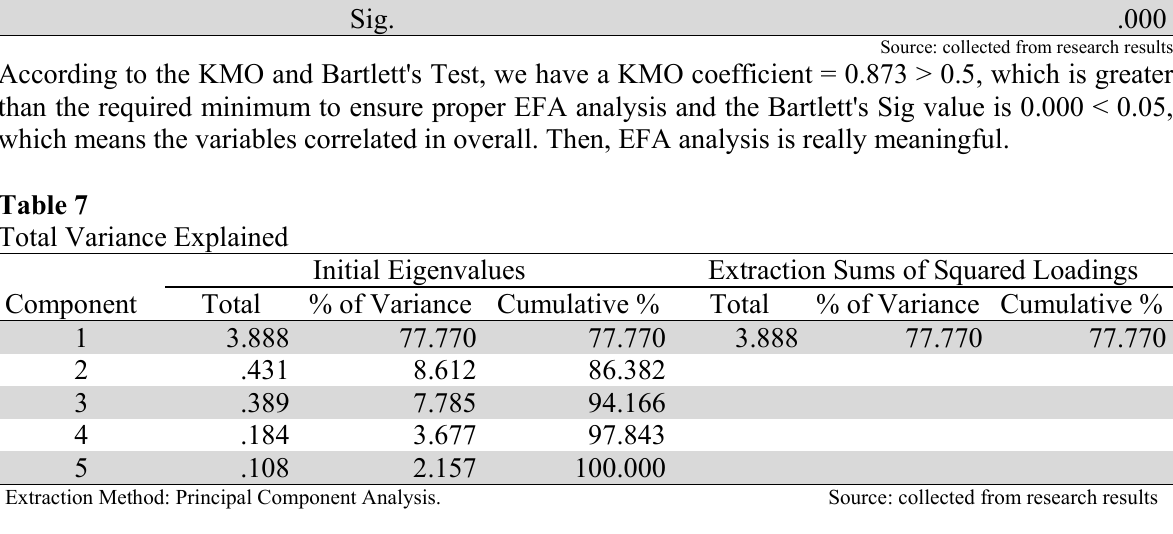
KMO and Bartlett's Test Kaiser-Meyer-Olkin Measure of Sampling Adequacy. Bartlett's Test of Sphericity